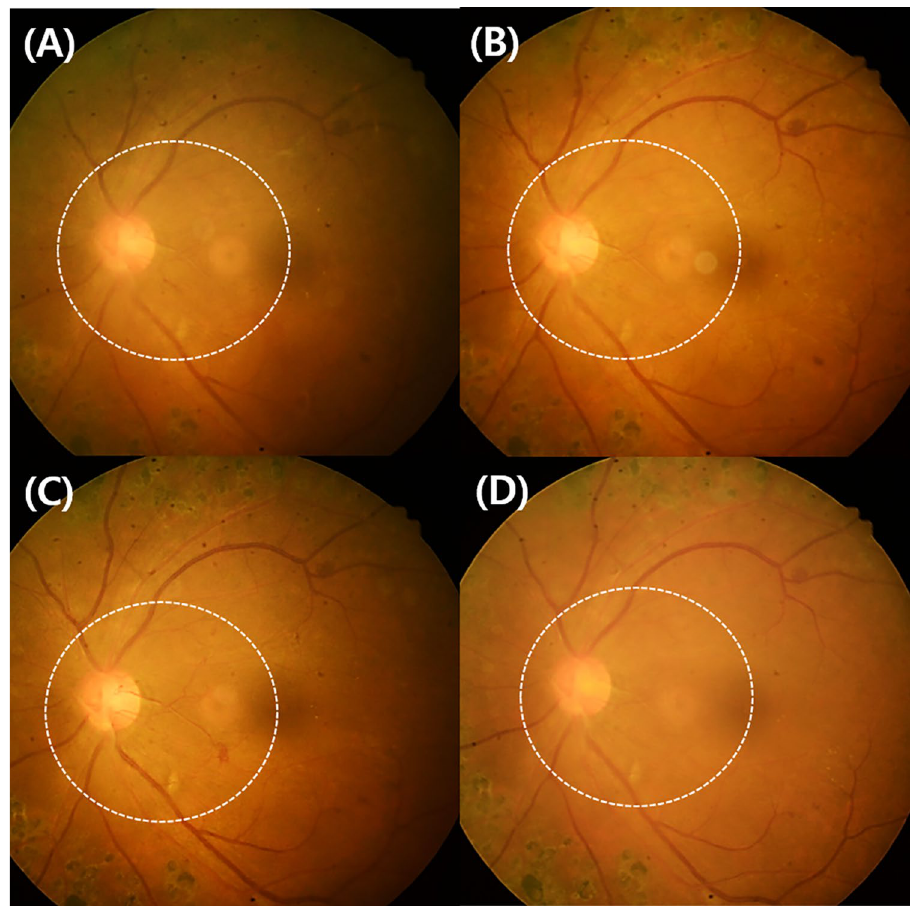
Figure 2. Change in the new vessel on the disc of case 1 before and after anti-vascular endothelial growth factor antibody injection (IVAI) treatment: ( A ) 1 month after the initial IVAI, ( B ) 2 months after the initial IVAI, ( C )